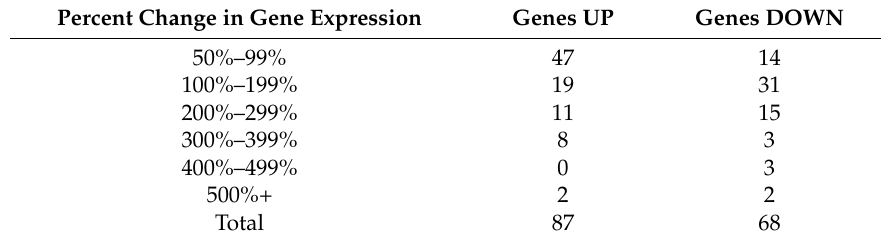
Table 23. Distribution of Genes Affected by GHK and Associated with Dendrites.